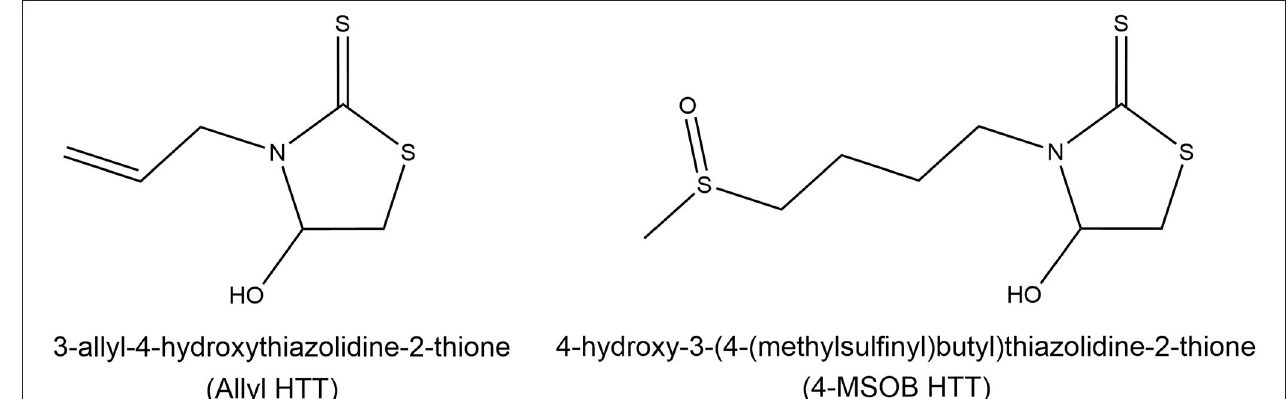
FIGURE 1 | Structures of the recently discovered heat-induced glucosinolate degradation products 3-allyl-4-hydroxythiazolidine-2-thione (allyl HTT, left) and 4-hydroxy-3-(4-(methylsulfinyl)butyl)thiazolidine-2-thione (4-MSOB HTT, right). Modified according to Hoffmann et al. (20).